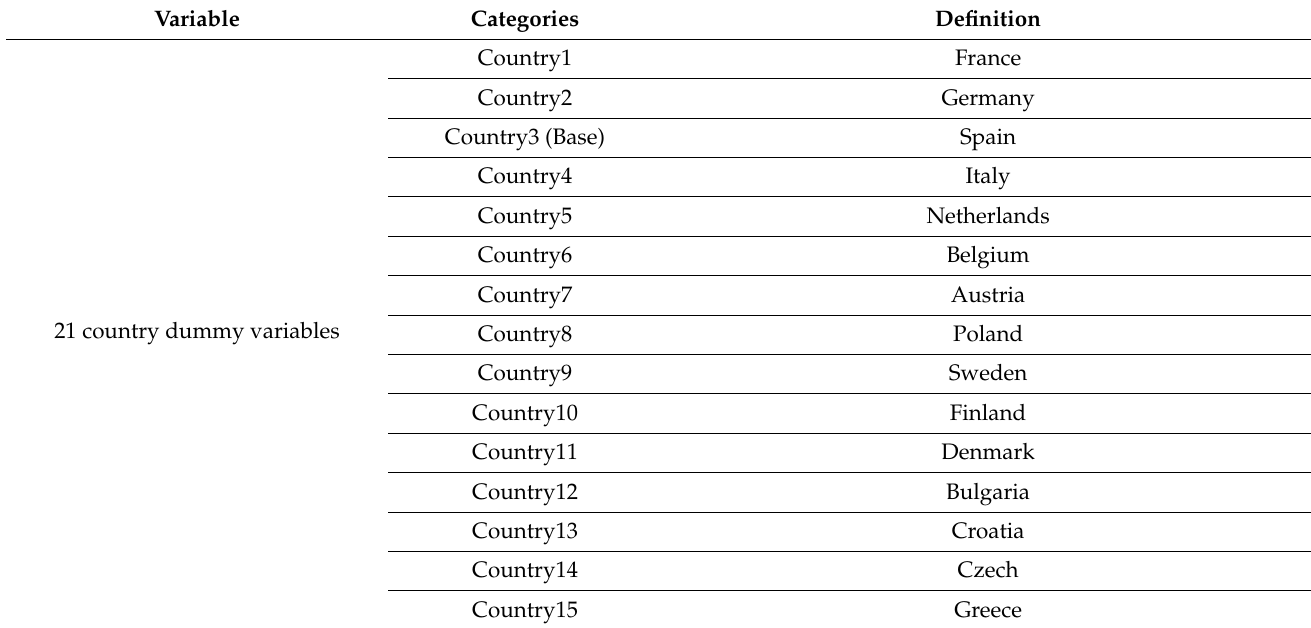
Table A2. Definitions of the independent